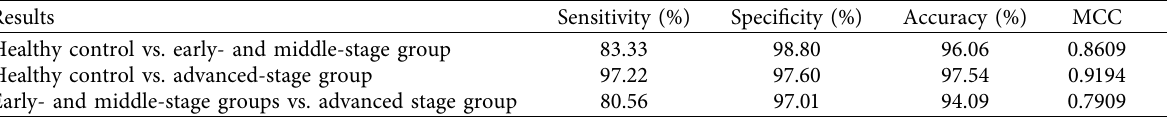
Table 2: Classification group for three models.